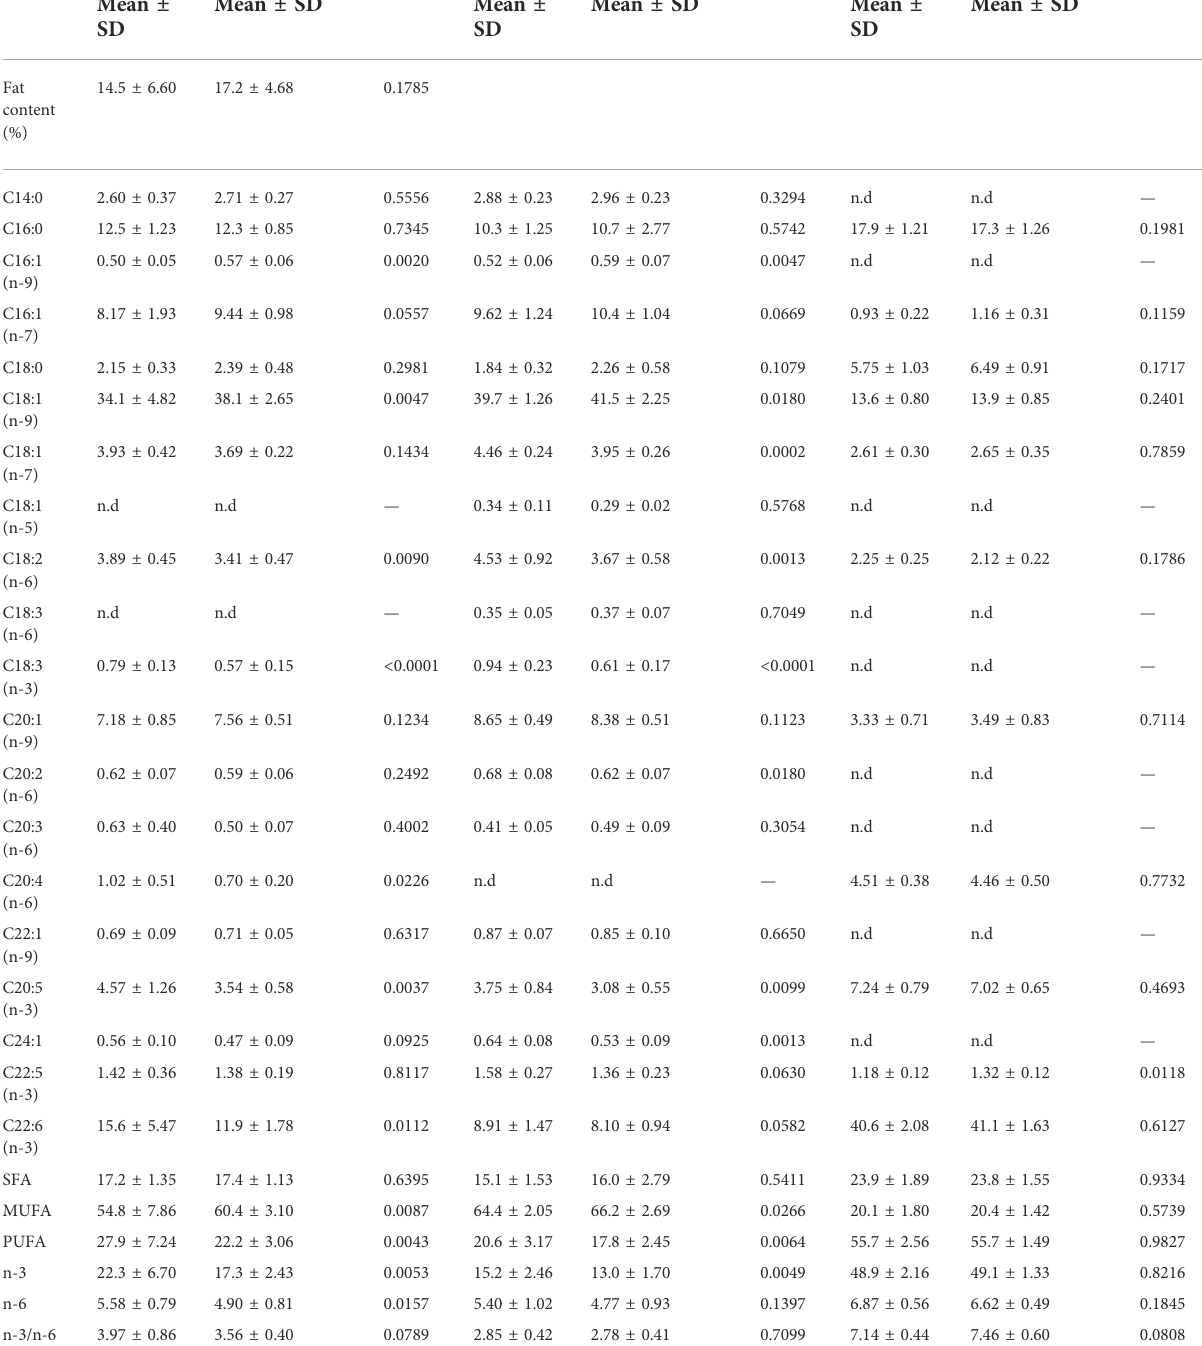
TABLE 6 Total fat content of liver and TL, PL, TAG fatty acid composition (% of total identi fi ed FA) of the control fed fi sh and experimental (yeast) fed fi sh.Dataarepresentedasmean±standarddeviation,( n =36intotalwith18fromeachfeedgroup,3technicalreplicates).Statisticalsigni fi cance was set at p -value <